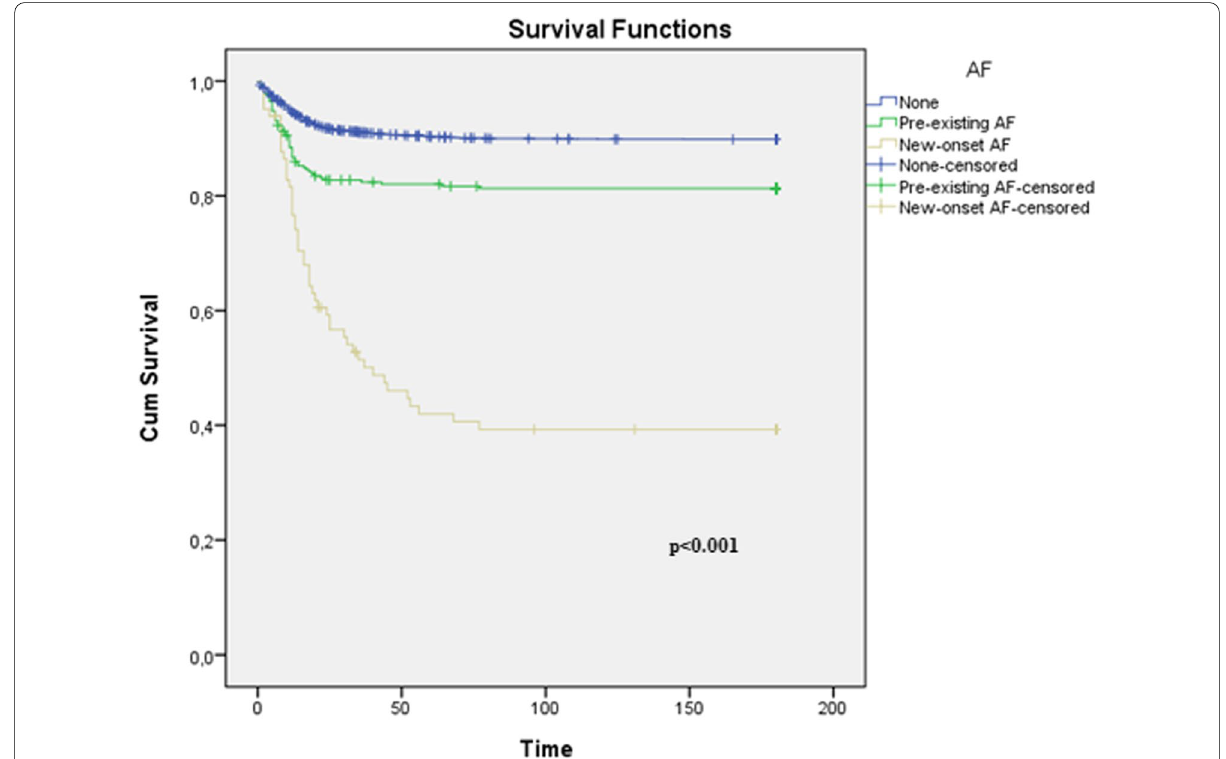
Fig. 1 Survival curves according to AF